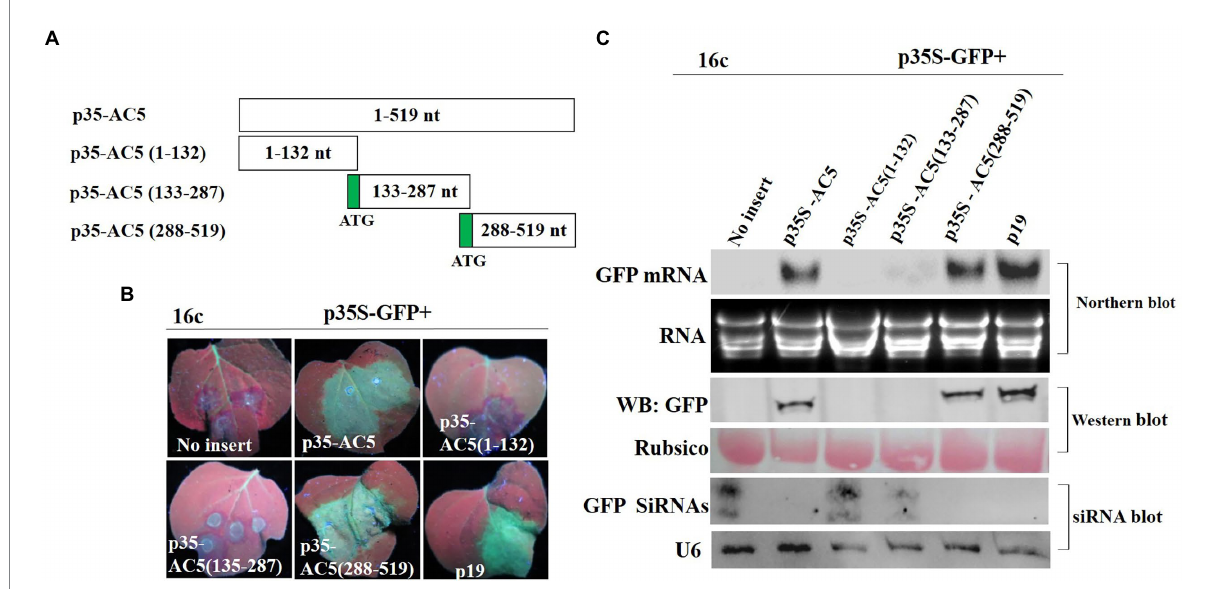
FIGURE 3 Identification of the AC5 region with RNA silencing suppressor activity. (A) Diagrams of the AC5 mutants. (B) Leaf patches were co-infiltrated with A . tumefaciens cultures harboring the p35S-GFP and empty pGreenII 62-SK vector, p35S-GFP + p35S-AC5, p35S-GFP + p35S-AC5(1–132), p35S- GFP + p35S-AC5(135–187), p35S-GFP + p35S-AC5(188–519), p35S-GFP + P19, p35S-AC5 and its mutants were photographed under UV light at 4 dpi. (C) Northern blot of GFP accumulation, GFP protein accumulation and siRNA blot of GFP siRNA accumulation in the Agrobacterium -infiltrated leaf patches as indicated in (B) . SYBR Safe DNA Gel staining of rRNA and Ponceau S staining of the subunit of Rubisco served as loading controls. U6 was the loading control in the siRNA blot.